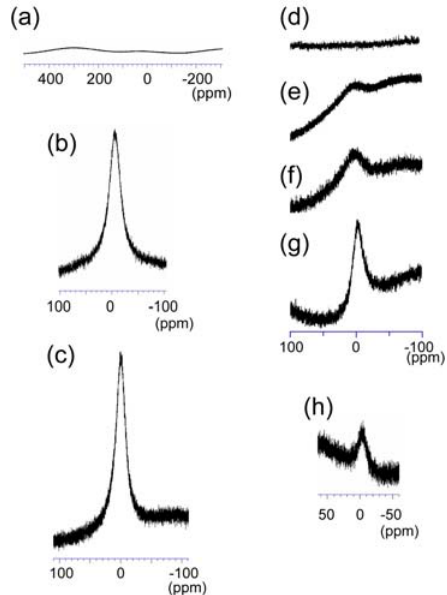
La } (a); oxidization of (a) with HNO 134 10 (c); 0.1 mM {Mo 3 (e); and 20 mM LaCl 3 3